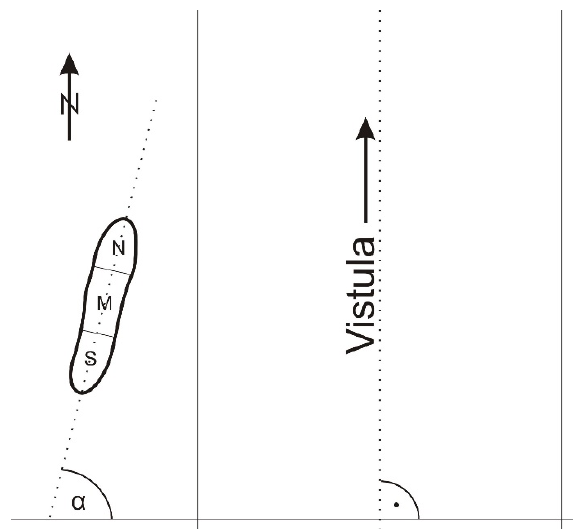
Figure 3. A sediment sampling scheme; α —angle between reservoir axis and the riverbed; and southern (S), middle (M) and northern (N)—parts of reservoir.